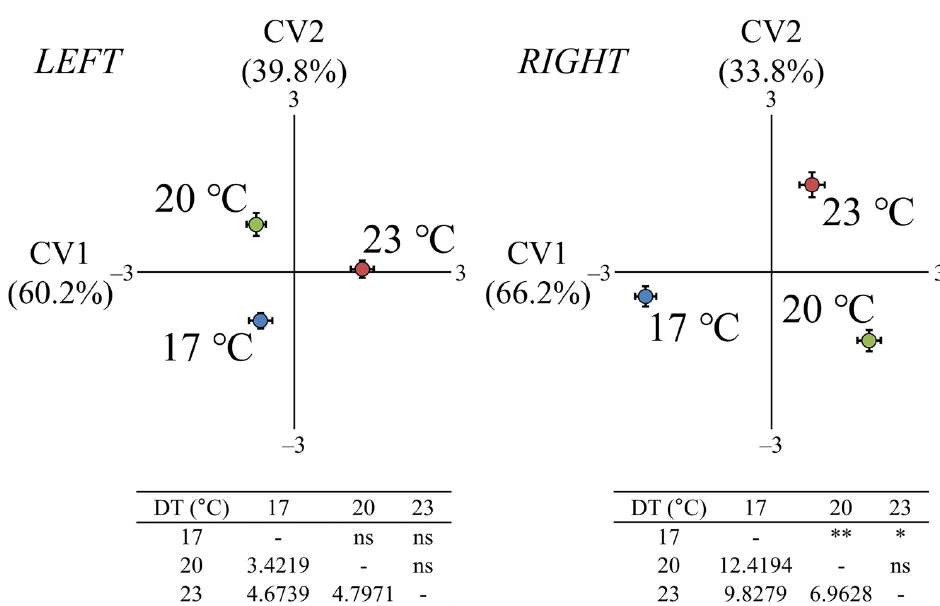
Figure 3. Effect of developmental temperature (17, 20, or 23 ◦ C) on the otolith shape of seabream early juveniles taken at 93–95 dph (days post-hatching). Means ( ± 2 SE) of the canonical scores are presented. Numbers in brackets are equal to the percentage of shape variance explained by each canonical variate (CV) axis. Squared Mahalanobis distances between the different groups and the respective significance levels are given for both left and right otoliths in the tables below the CV graphs. ns p > 0.05, * p < 0.05, ** p <